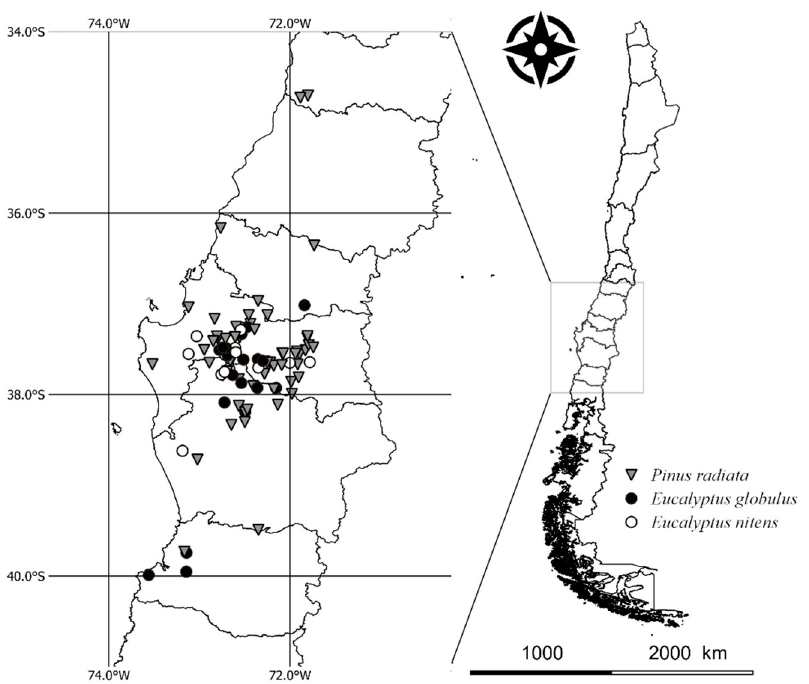
Figure 1. Location of sample sites for E. globulus (filled circle), E. nitens (open circle), and P. radiata (grey triangle) trees growing in central Chile (map includes administrative divisions of the country).